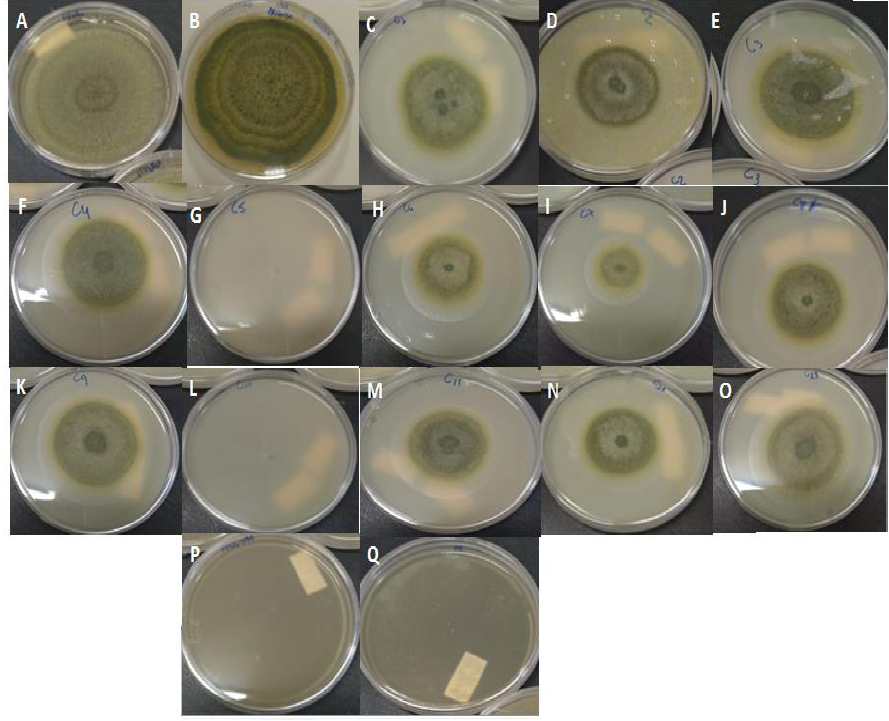
Figure 1. Images of Petri dishes inoculated with A. nomius and treated with blank NLC, PEO-loaded NLC (F1-F13), Carbendazim, or non-encapsulated PEO, after 10 days of incubation: ( A ) fungal control; ( B ) negative control (blank NLC); ( C ) F1; ( D ) F2; ( E ) F3; ( F ) F4; ( G ) F5; ( H ) F6; ( I ) F7; ( J ) F8; ( K ) F9; ( L ) F10; ( M ) F11; ( N ) F12; ( O ) F13, ( P ) positive control (Carbendazim 250 μg mL −1 ) and ( Q ) non- encapsulated PEO (250 μg mL −1 ).